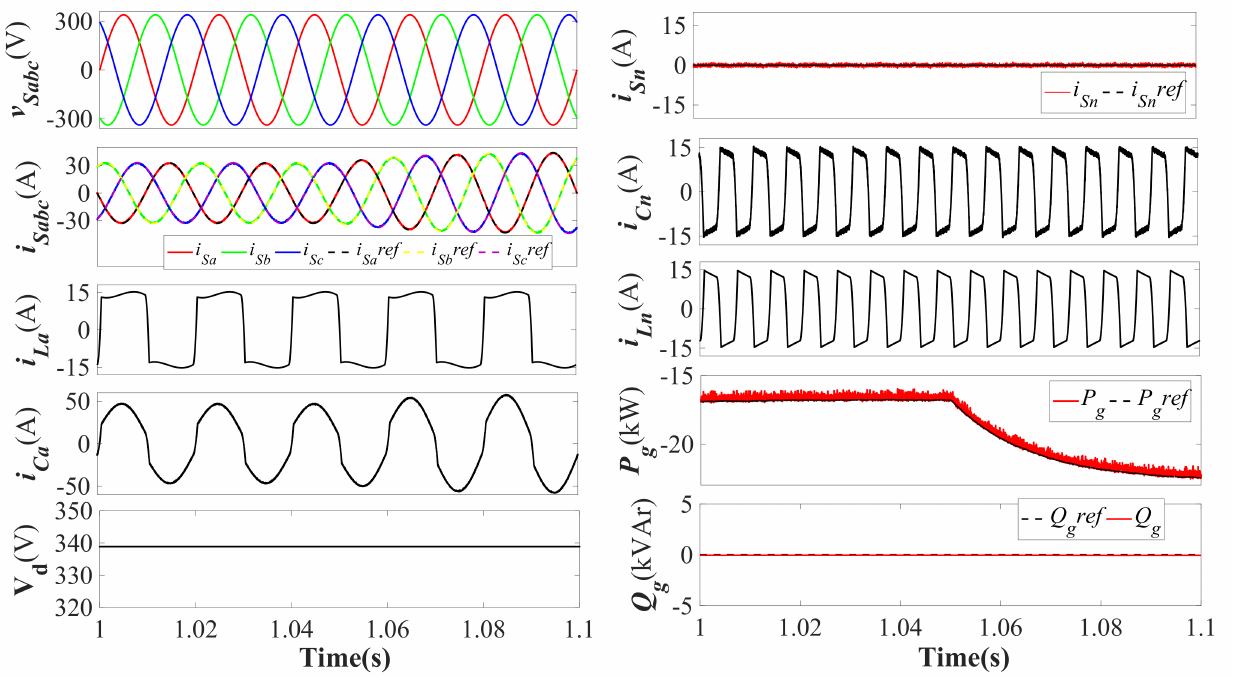
Figure 10. Dynamic performance during fixed power mode of v sabc , i sabc , i Ca , V d , i La , i Sn , i Cn , i Ln , P g , and Q g .